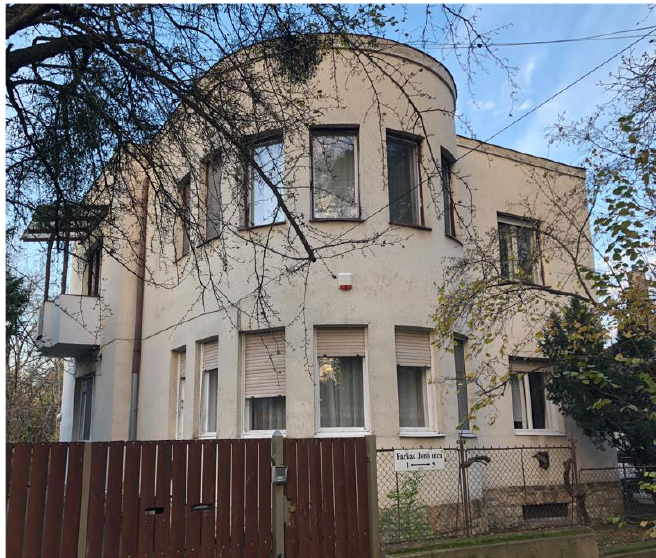
Figure 12. 1 Jen ő Farkas street nowadays. Architect: Victor Bohm, 1937. Source: Lovra 2021. Figure 12. 1 Jen˝o Farkas street nowadays. Architect: Victor Bohm, 1937. Source: Lovra 2021. The identified, still-standing buildings of Victor Bohm in Miskolc, Hungary: